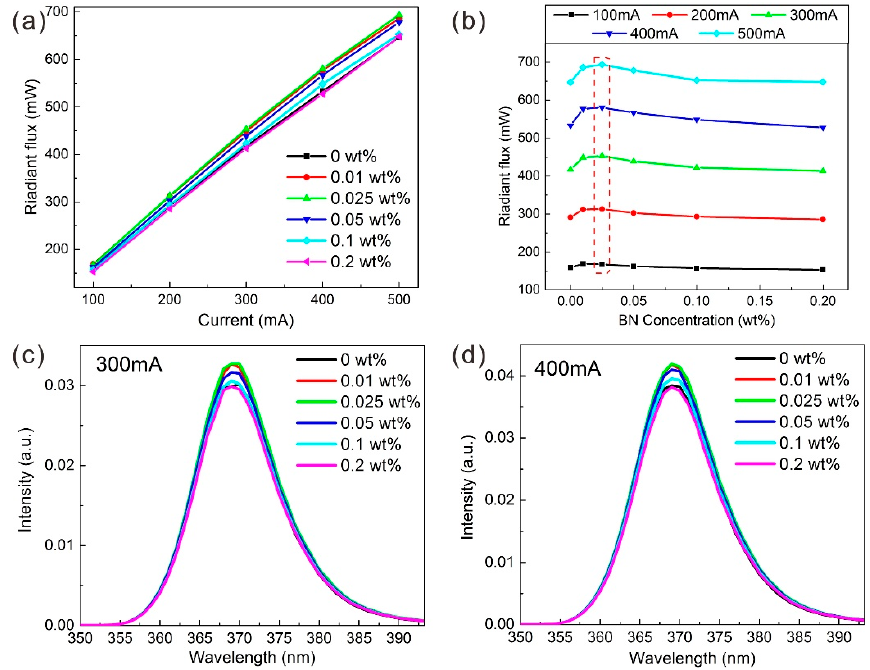
Figure 5. ( a ) The radiant flux of the UVLED versus current, for different BN concentrations; ( b ) the radiant flux versus BN concentration, for different currents. ( c ) The electroluminescence (EL) spectrum of the UVLED at 300 mA for different BN concentrations; ( d ) EL spectrum at 400 mA.